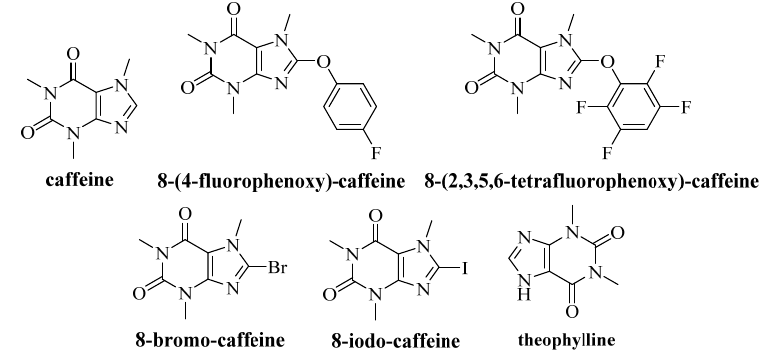
Figure 1. Methylxanthines